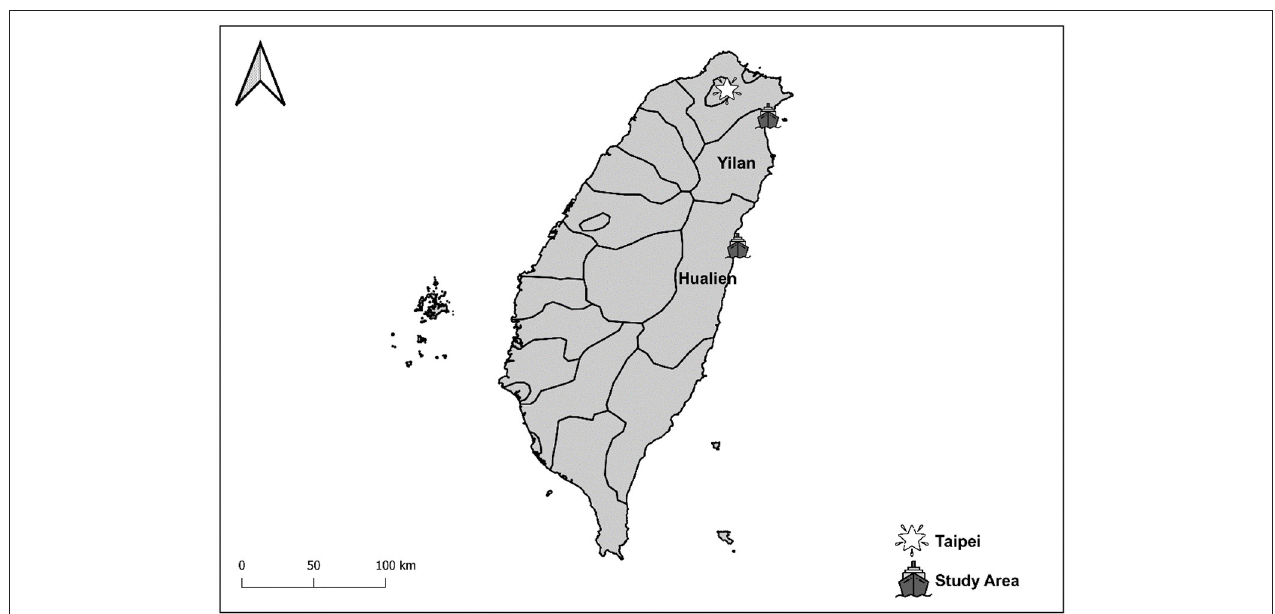
FIGURE 1 | Study area and sample